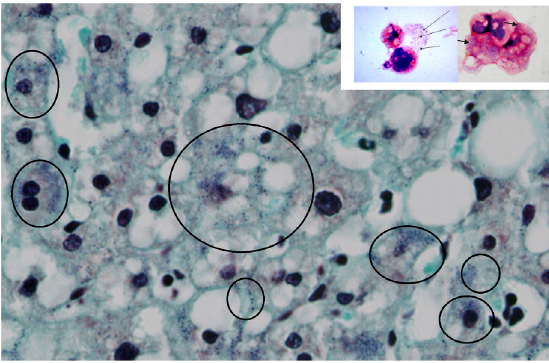
Figure 2. Human liver histochemistry. Gram staining of ahuman liver (magnification, ×80). After the Gram stain, human liver cells displayed fine blue granules that, for didactic reasons, are enclosed in the black circles, but they can be seen scattered in the parenchyma. Note the similarities between the amoebal Mimiviruses appearing as blue granules (small picture frame and Figure 1) with the human blue granules. In the human cells, the gram positive granules appear as fine granules and are distinct from bacteria and other pigment, like lipofucsin, that is also present (brown colour).